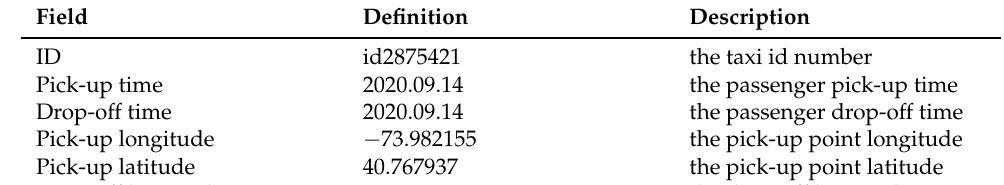
Table 3. Data description.